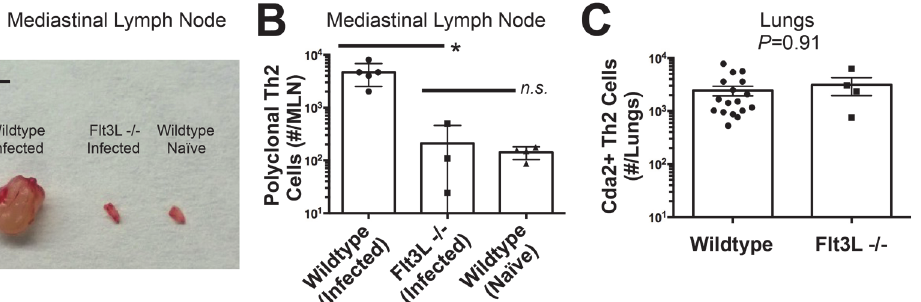
Fig 3. Lymphoid Priming is Dispensible for Pulmonary Th2 Cell Induction during Cryptococcal Infection. ( A ) Lymphadenopathy of mediastinal lymph nodes (MLN) after 14 days post-infection with strain KN99 α . ( B ) Quantification of IL-5+ IL-13+ polyclonal Th2 cells from the MLN in wild-type and Flt3L − /